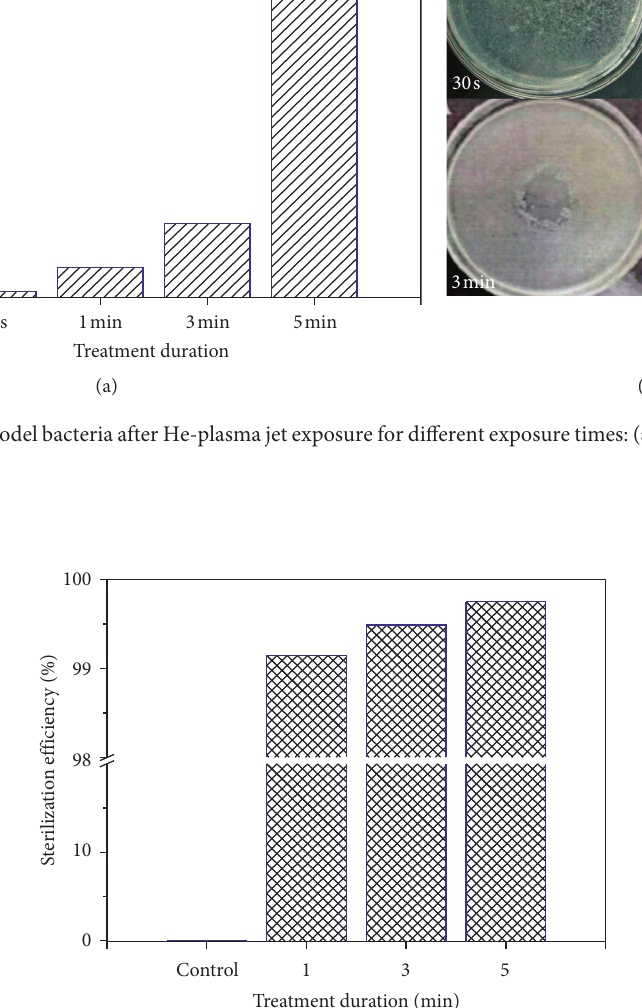
Figure 9: Effect of treatment duration on water